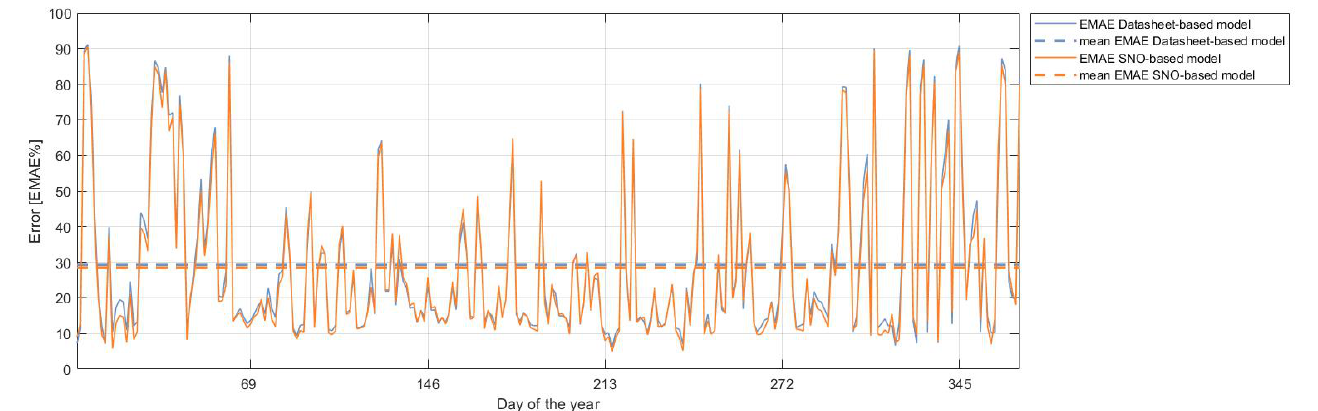
Figure 6. Envelope-weight mean average error (EMAE) comparison between the two physical models: the datasheet-based and the SNO-based models. The dashed line is the average EMAE computed for the entire